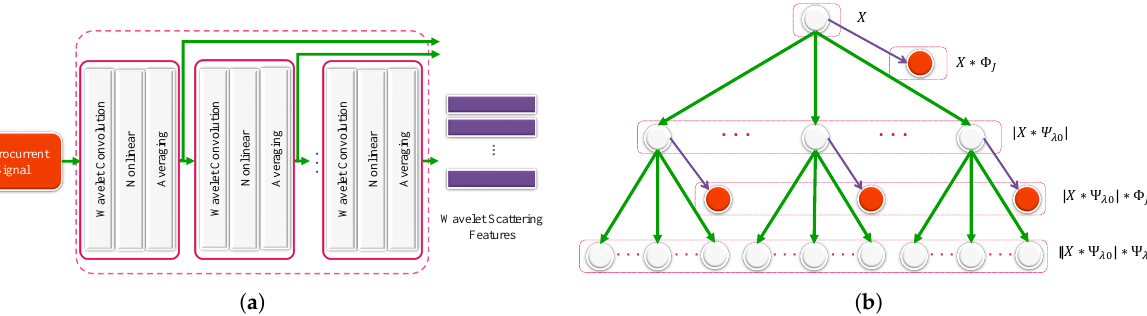
Figure 5. Principle of wavelet scattering transform. ( a ) Framework of wavelet scattering network. ( b ) Structure of wavelet scattering